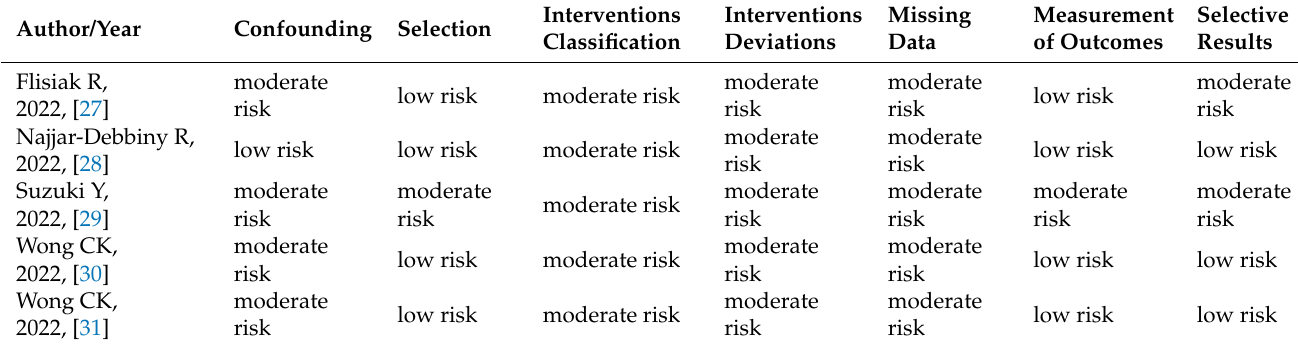
Table 2. Risk bias of five retrospective cohort